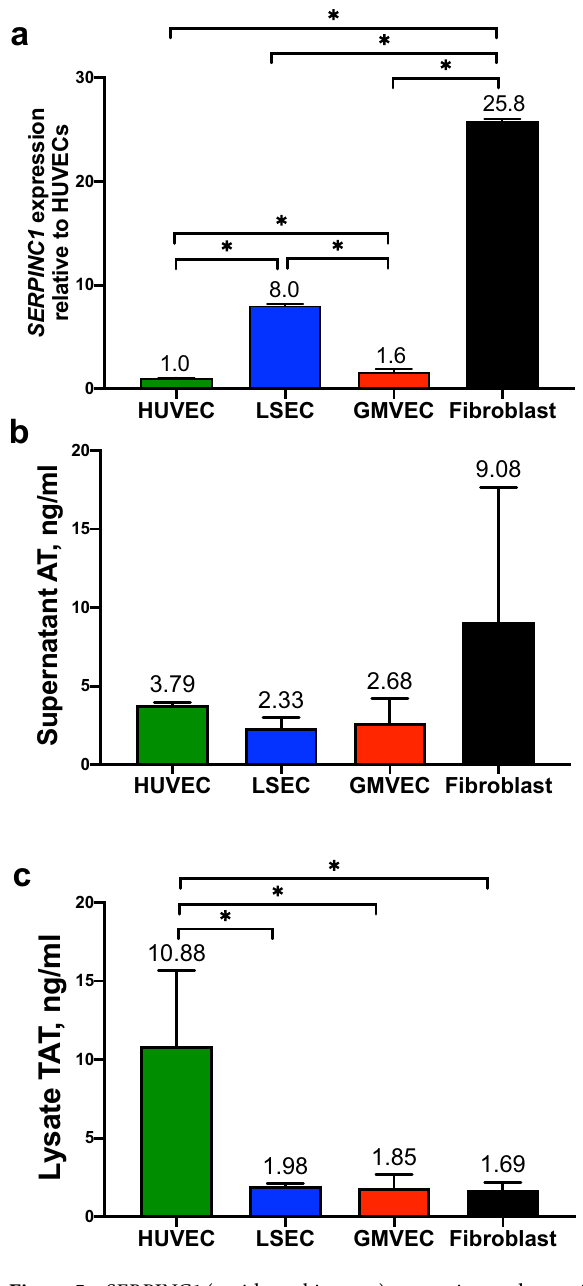
Figure 5. SERPINC1 (antithrombin gene) expression and quantification of AT and TAT in ECs and fibroblasts. ( a ) The expression levels of SERPINC1 in each cell type were analyzed by real time-PCR and quantified relative to HUVEC levels after normalization to GAPDH in each PCR analysis. Data shown are means + SD from three separate RNA extractions for each cell type. * p < 0.0001. ( b ) Levels of AT via ELISA were quantified in supernatant of HUVECs (n = 3), LSECs (n = 4), GMVECs (n = 3), and fibroblasts (n = 5). ( c ) Quantification of TAT in the lysate/cell membrane fraction of HUVECs, LSECs, GMVECs, and fibroblasts (n = 3 for each cell type). * p <